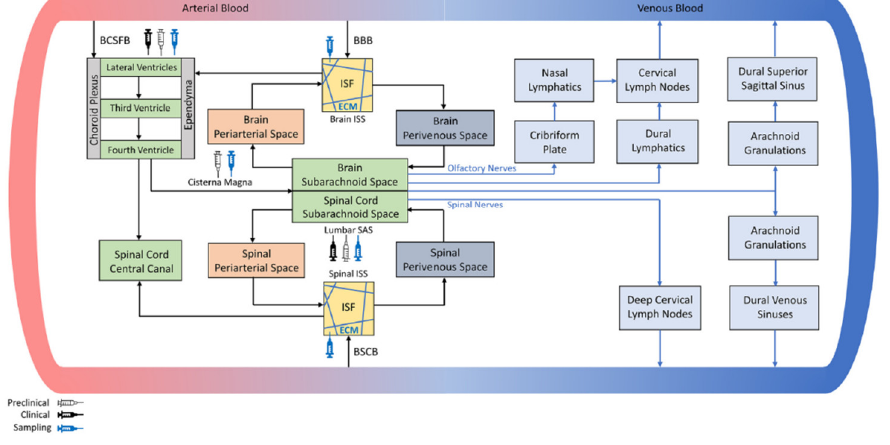
Figure 1. Schematic representation of the CSF net flow within the brain and spine